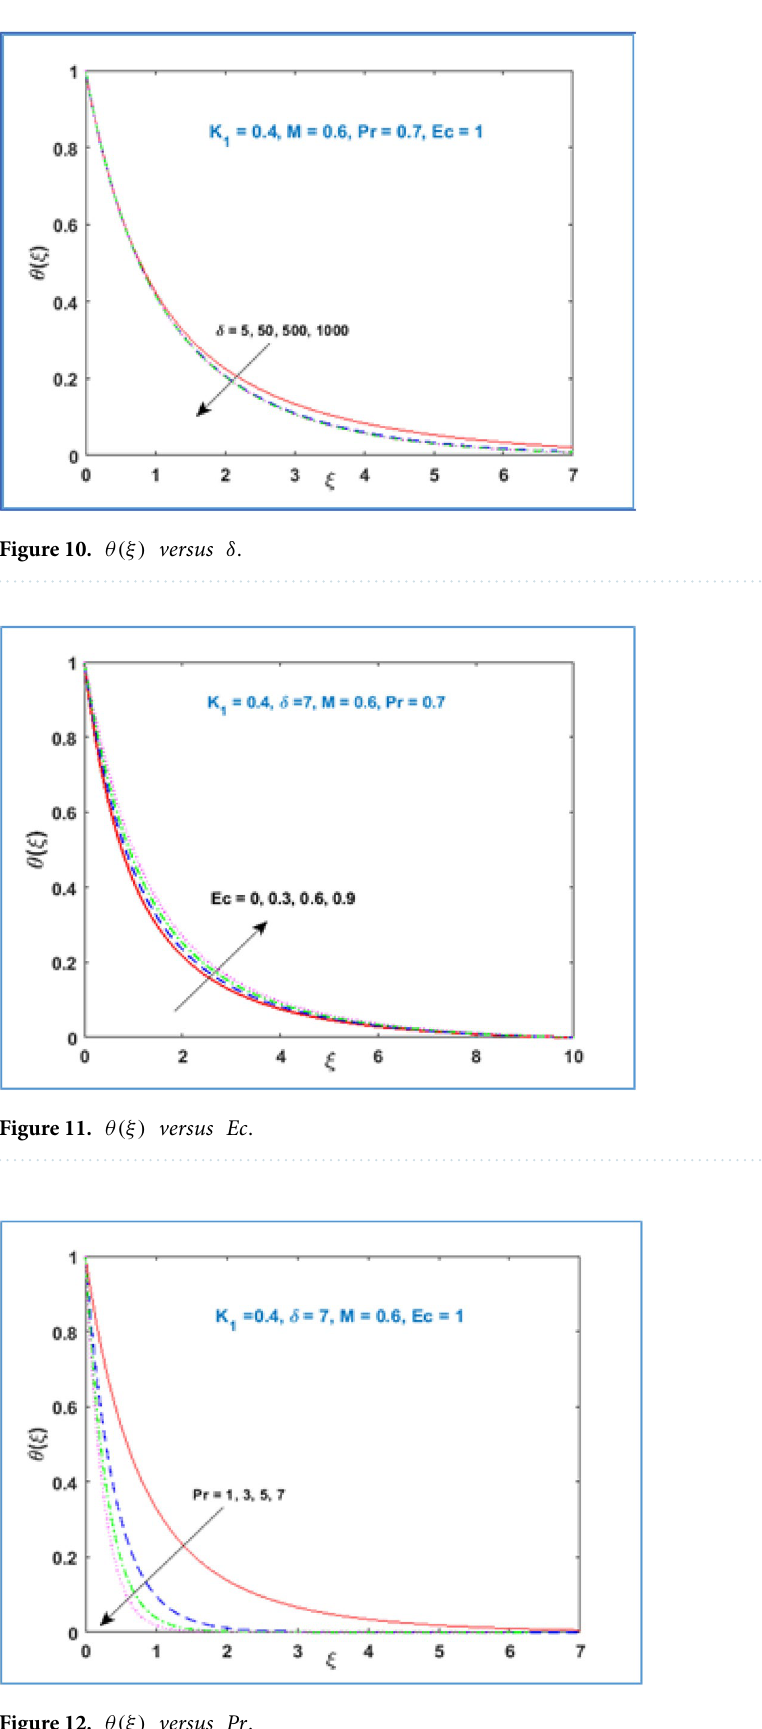
Figure 12. θ(ξ) versus Pr